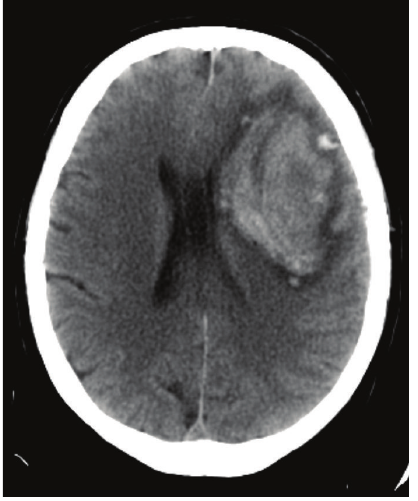
Figure 4: Left frontal